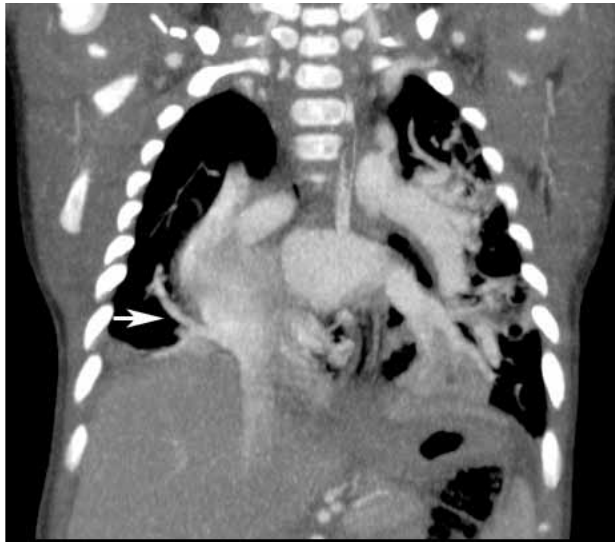
Fig. 4. Coronal MIP showing the scimitar vein (arrow) and its point of insertion into the IVC. Note the plethoric left lung.